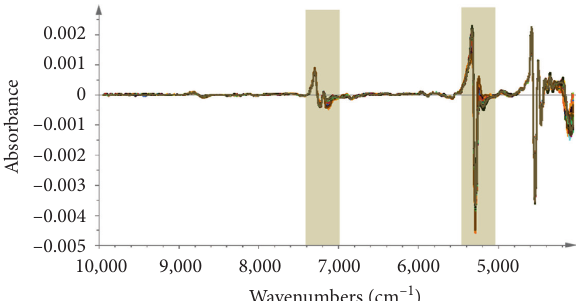
Figure 5: Spectra preprocessed by MSC+SD/SG of all samples and the efficient spectral intervals selected by PCR for the prediction of moisture content.